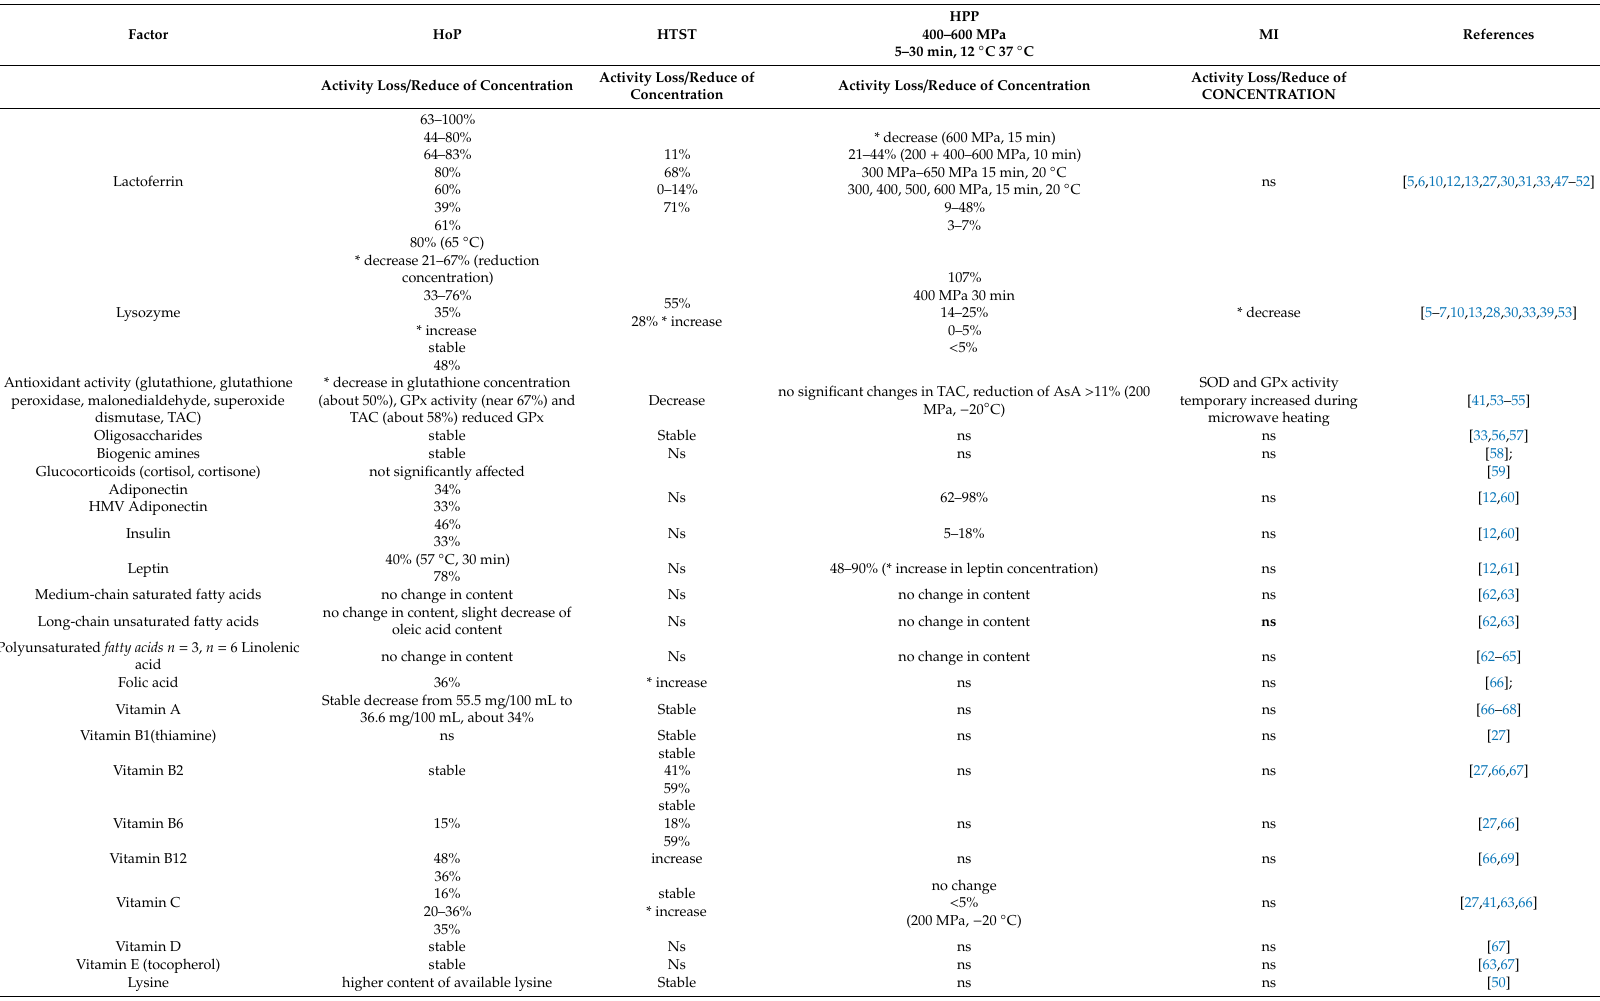
Table 2. E ff ects of di ff erent type of processing (Holder Pasteurization, High-Temperature Short-Time, High Pressure Processing and Microwave Irradiation) on human milk